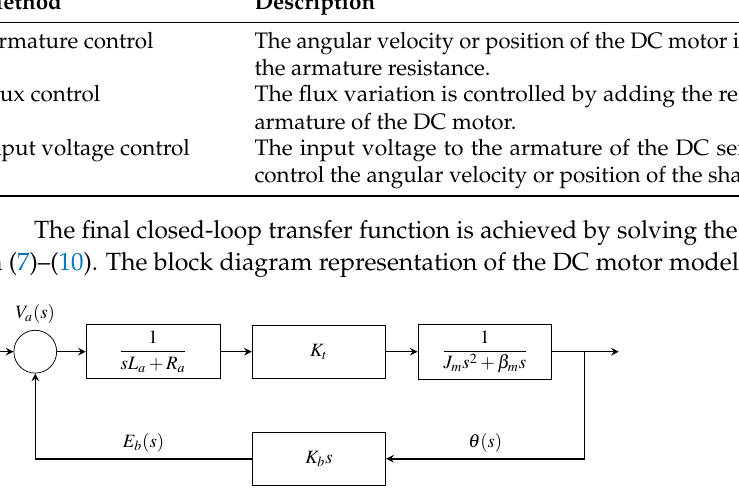
Figure 1. Block diagram of the DC